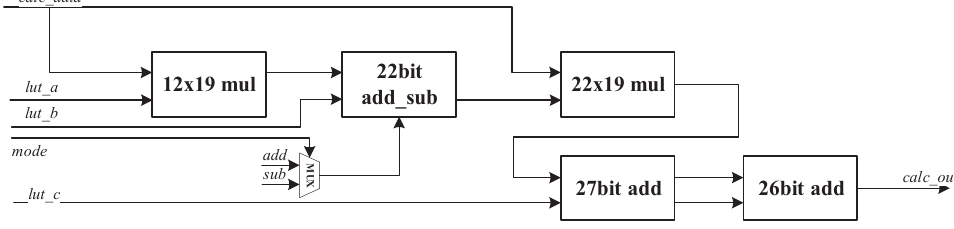
Figure 9. Calculation